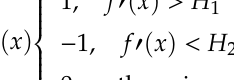
Figure 7. Depth map process: ( a ) Depth map h ( x, y ) of fastener area; ( b ) vertical average value f(x) across the horizontal “narrow band” area of the fastener; ( c ) partial enlarged display of figure ( b ) (the vertical axis ranges from 20 to 30).